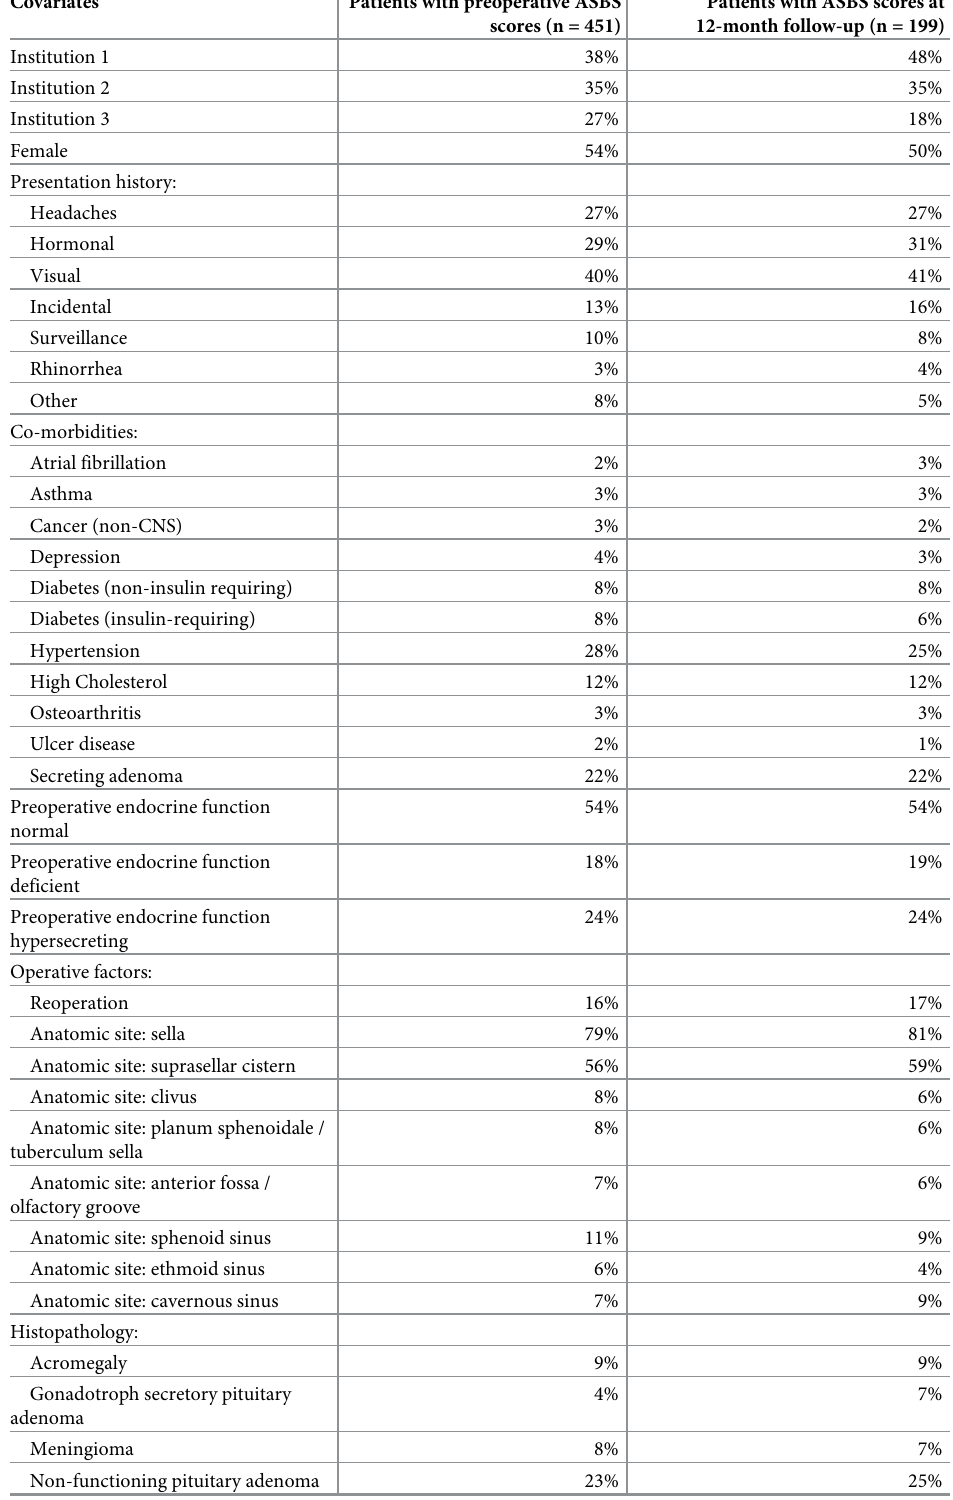
Table 1. Descriptive statistics. Covariates comprising < 1% of the dataset were excluded.